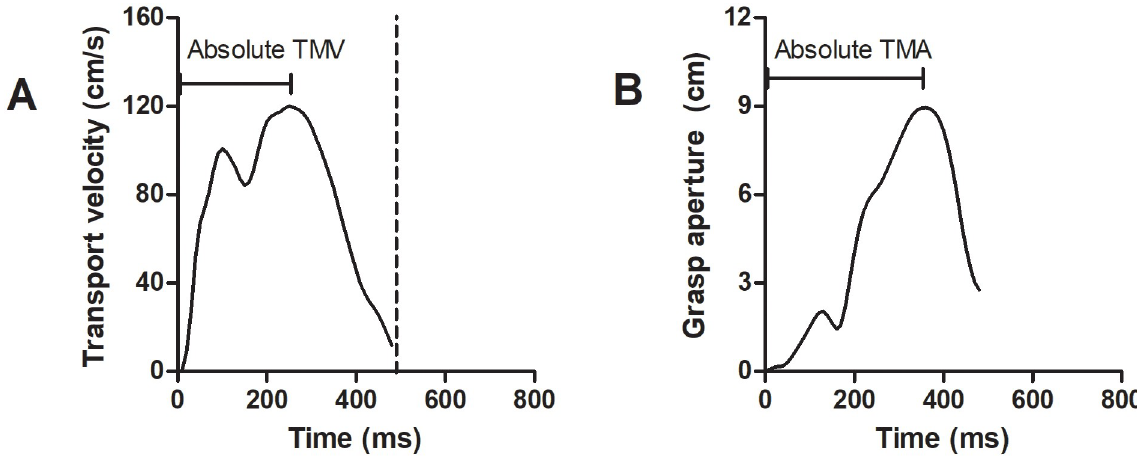
Fig 2. Dependent variables. Transport velocity (A) and grasp aperture profiles (B).